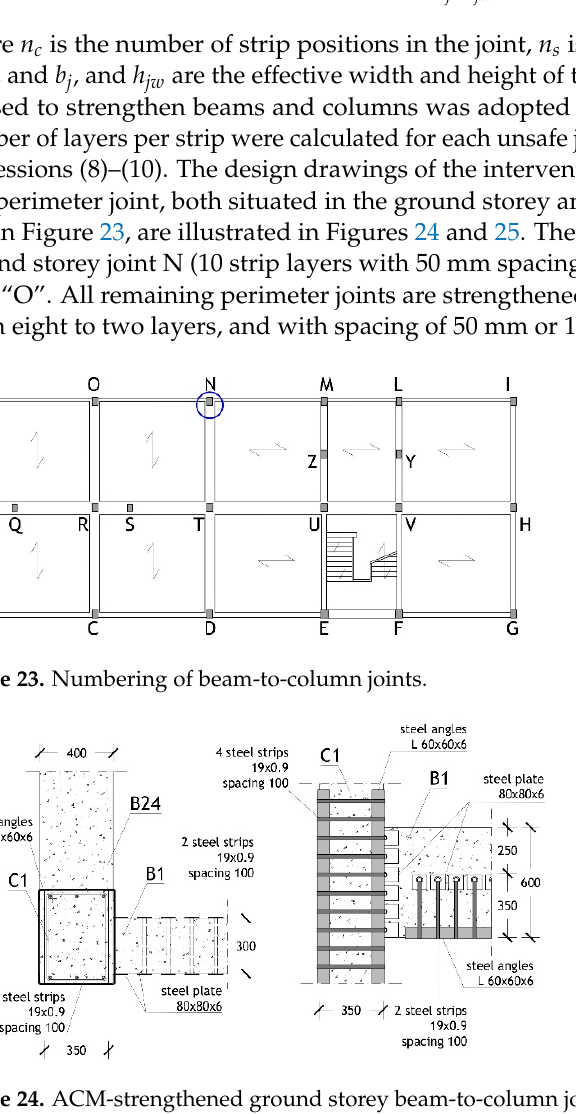
Figure 25. ACM-strengthened ground storey beam-to-column joint N. The pre- and post-strengthening demand/capacity ratios for a selected set of most stressed joints, listed in Table 5, highlight that safe stress states are reached in retrofitted conditions, like for beams and columns. The cost of the structural intervention, demolition, and reconstruction of the involved portions of façade infills and partitions included, amount to about 150 Euro/m 2 , i.e., 25– 30% lower than the cost estimated for traditional retrofit strategies, like RC-based jacket- ing of beams, columns and joints, incorporation of additional earthquake-resistant struc- tural members, etc. The latter strategy would also considerably increase the lateral stiff- ness of the structure, which is not motivated by the displacement performance in current state and, at the same time, could cause an unfavourable growth of storey shears. Table 5. Demand/capacity DCR ratios—selected beam-to-column joints. Joint Type